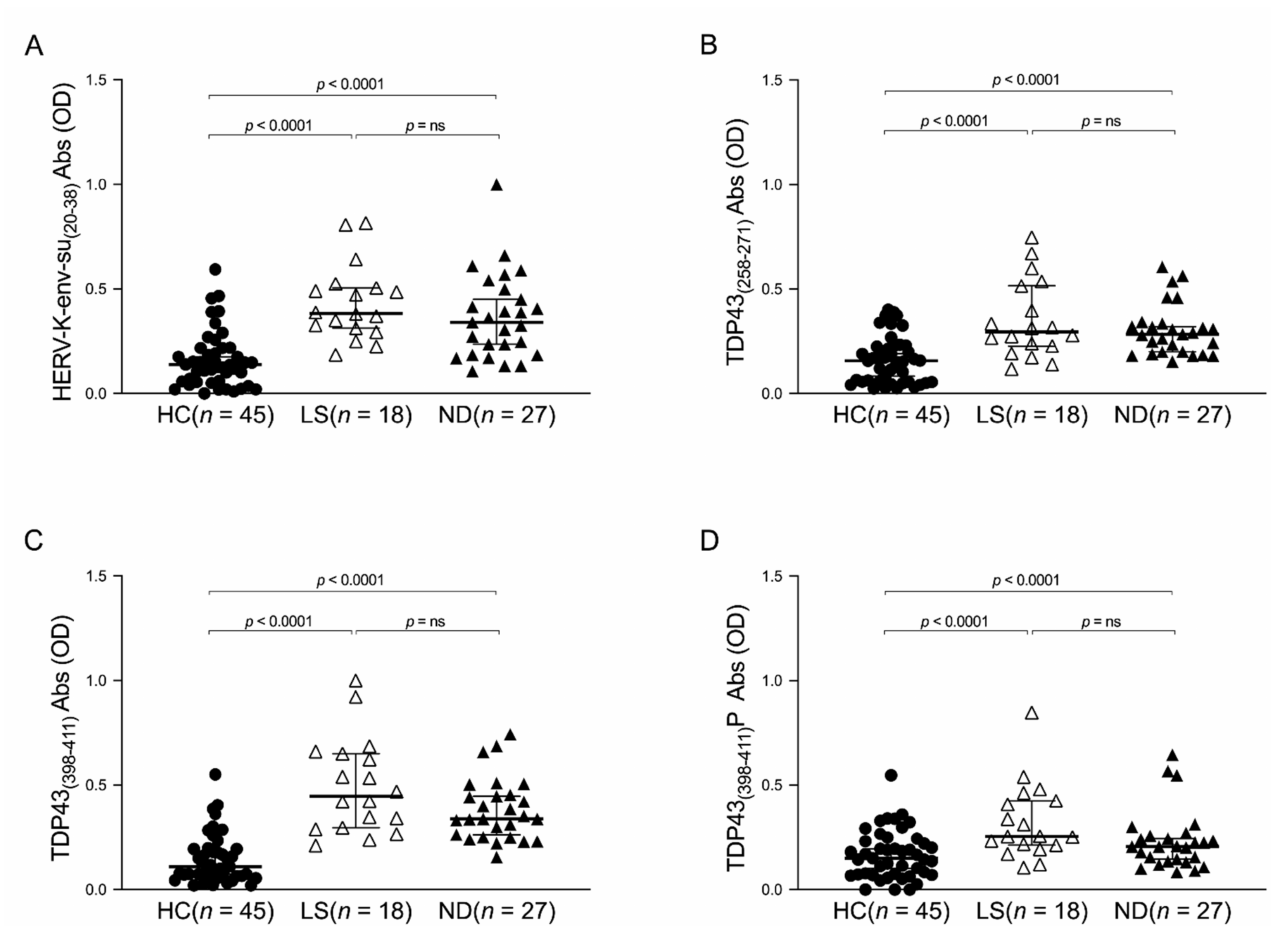
Figure 2. ELISA-based analysis of Abs reactivity against TDP-43- and HERV-K-derived peptides in ALS-ND, ALS-LS, and HCs groups. Plasma samples were tested against HERV-K-env-su (20–38) ( A ), TDP-43 (258–271) ( B ), TDP-43 (398–411) ( C ), and TDP-43 (398–411) P ( D ) peptides. A Kruskal–Wallis test and Dunn’s post hoc analysis were performed. Scatter plots represent the median, and the p -value is indicated in the upper part of each